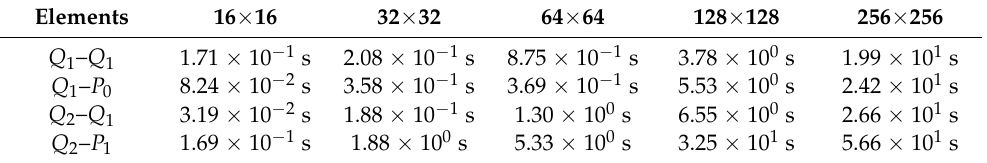
Table 2. Solve time of finite element methods for 16 × 16, 32 × 32, 64 × 64, 128 × 128, and 256 × 256. Elements